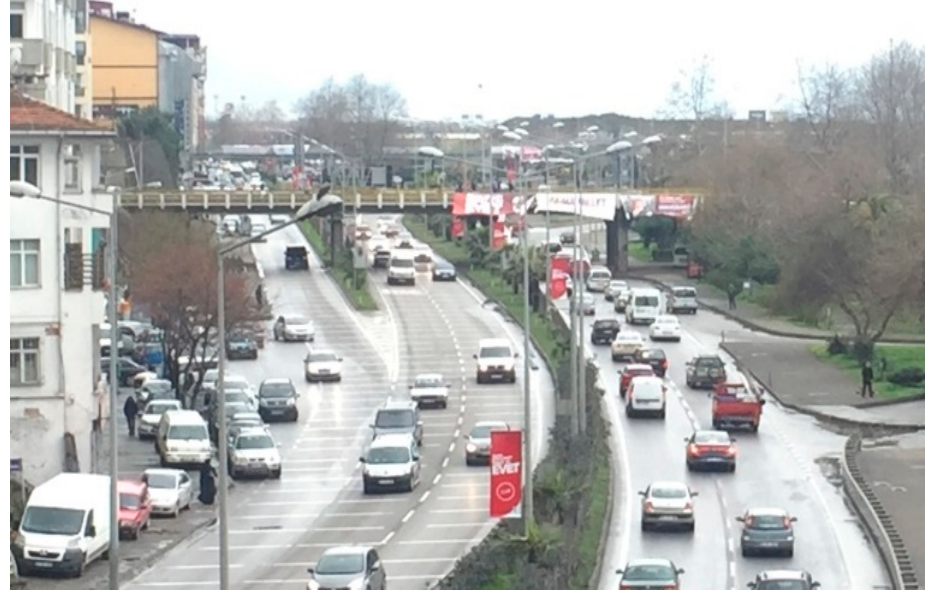
Figure 4. Photographs used in the